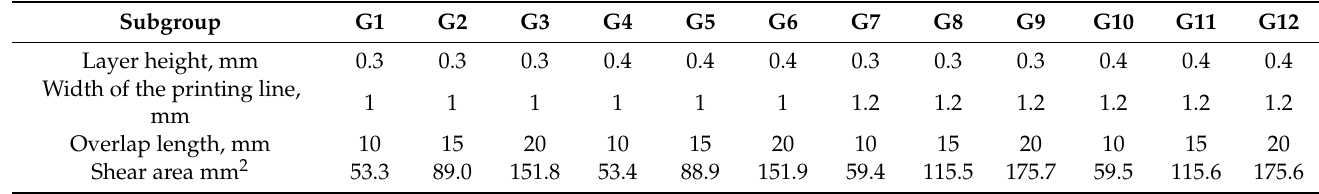
Table 3. Subgroups of the printed specimens with 11 lines.